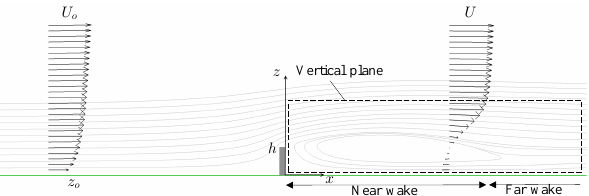
Figure 1. Simulated turbulent flow around a 2-D fence of height h and the vertical plane of interest. The flow is simulated with the model described in Sect.